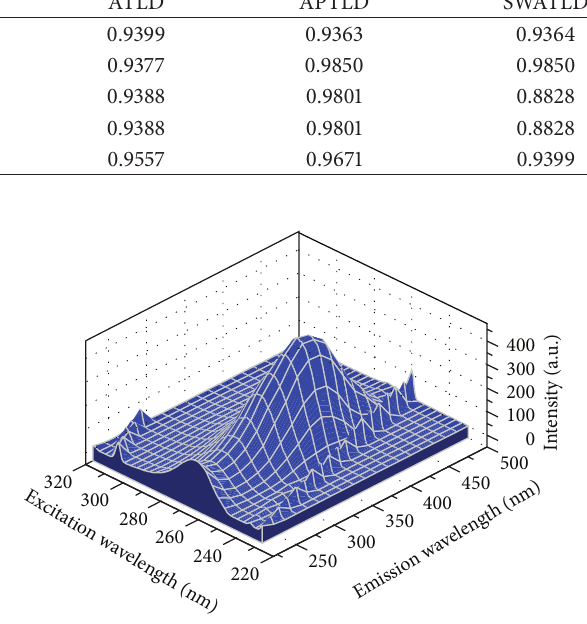
Figure 1: The excitation-emission matrix fluorescent spectrum of a mixture with excitation and emission wavelengths varying from 230 to 500 nm and from 230 to 320 nm,